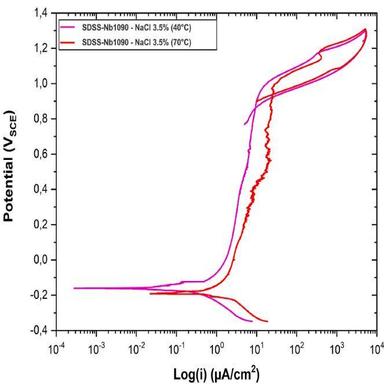
Cyclic polarization curves of heat-treated SDSS-Nb samples, 3.5% NaCl solution at 40 ◦C and 70 ◦C.